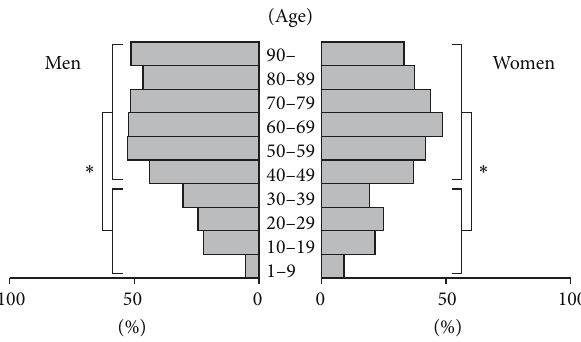
Figure 2: Prevalence of palatine tonsilloliths by sex and age